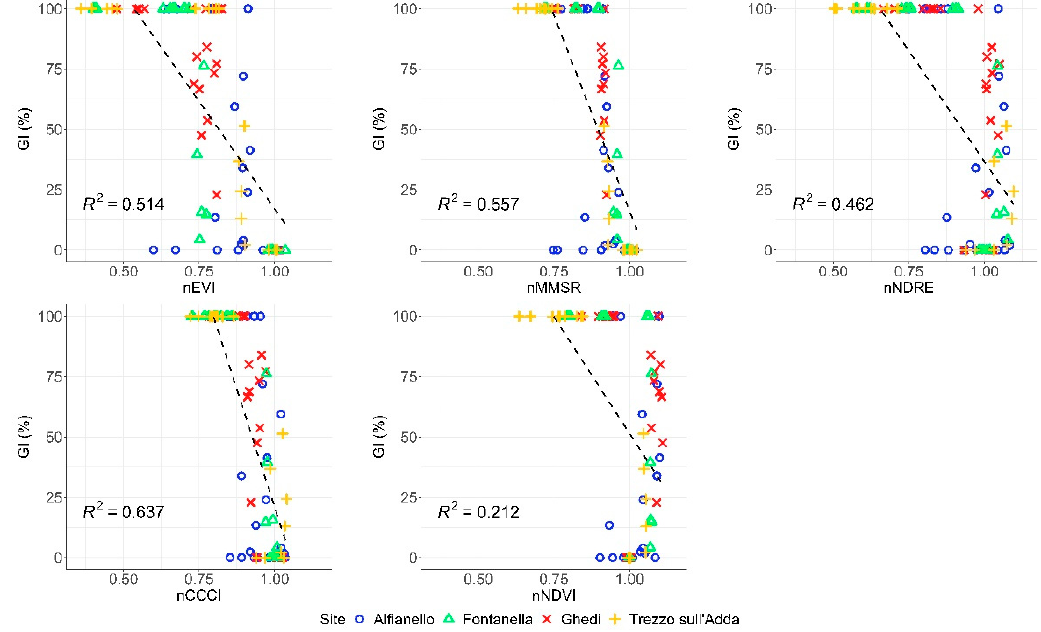
Figure 2. Linear relationships between the ground-measured frost index of a white mustard cover crop (GI) and the tested normalized vegetation indices, with the corresponding coefficients of determination (R 2 , unitless). Regression lines are reported as dashed